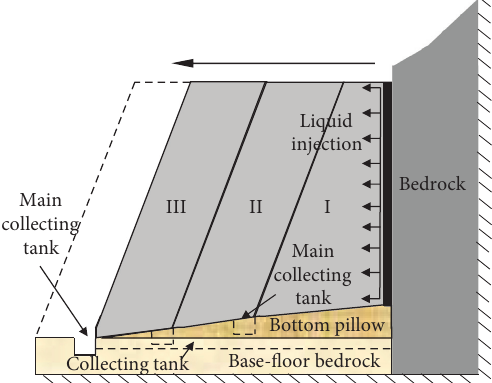
Figure 1: A growable pile structure for heap leaching of rare